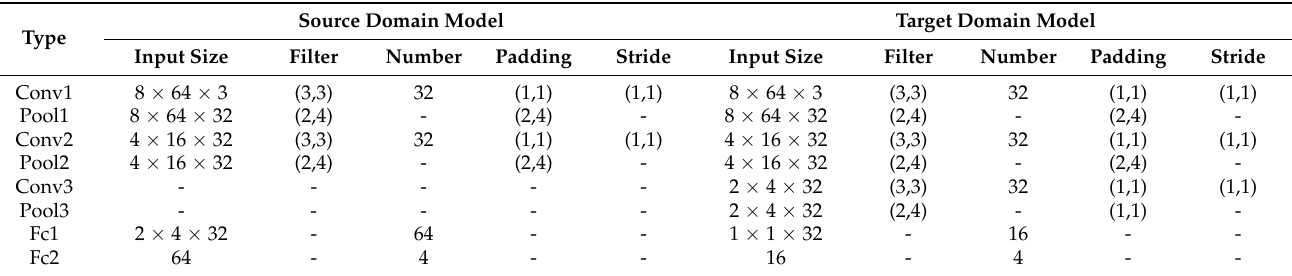
Table 7. Source domain model and target domain preliminary model network structure.